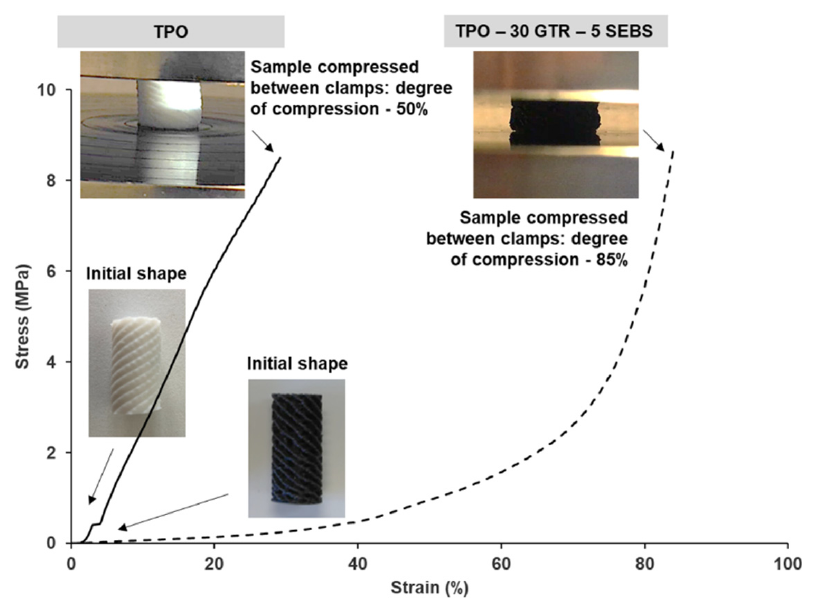
Figure 11. Stress–strain compression curves for TPO and TPO-30 GTR-5 SEBS samples.